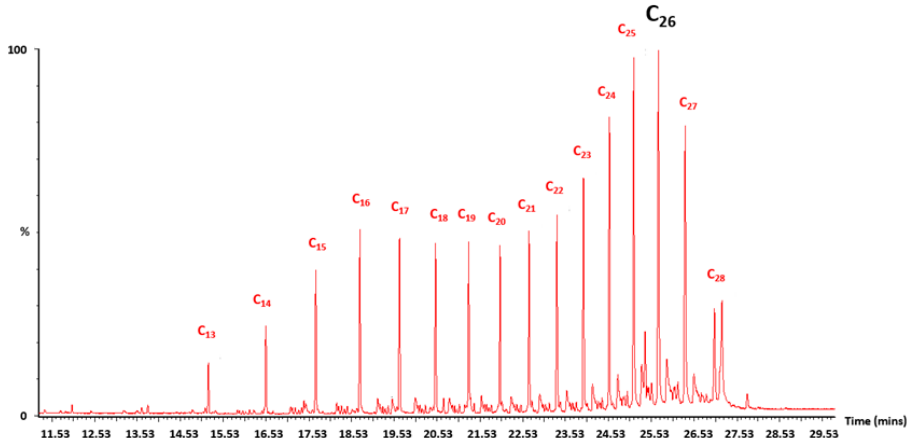
Figure A4. Thermal desorption chromatogram for R1.